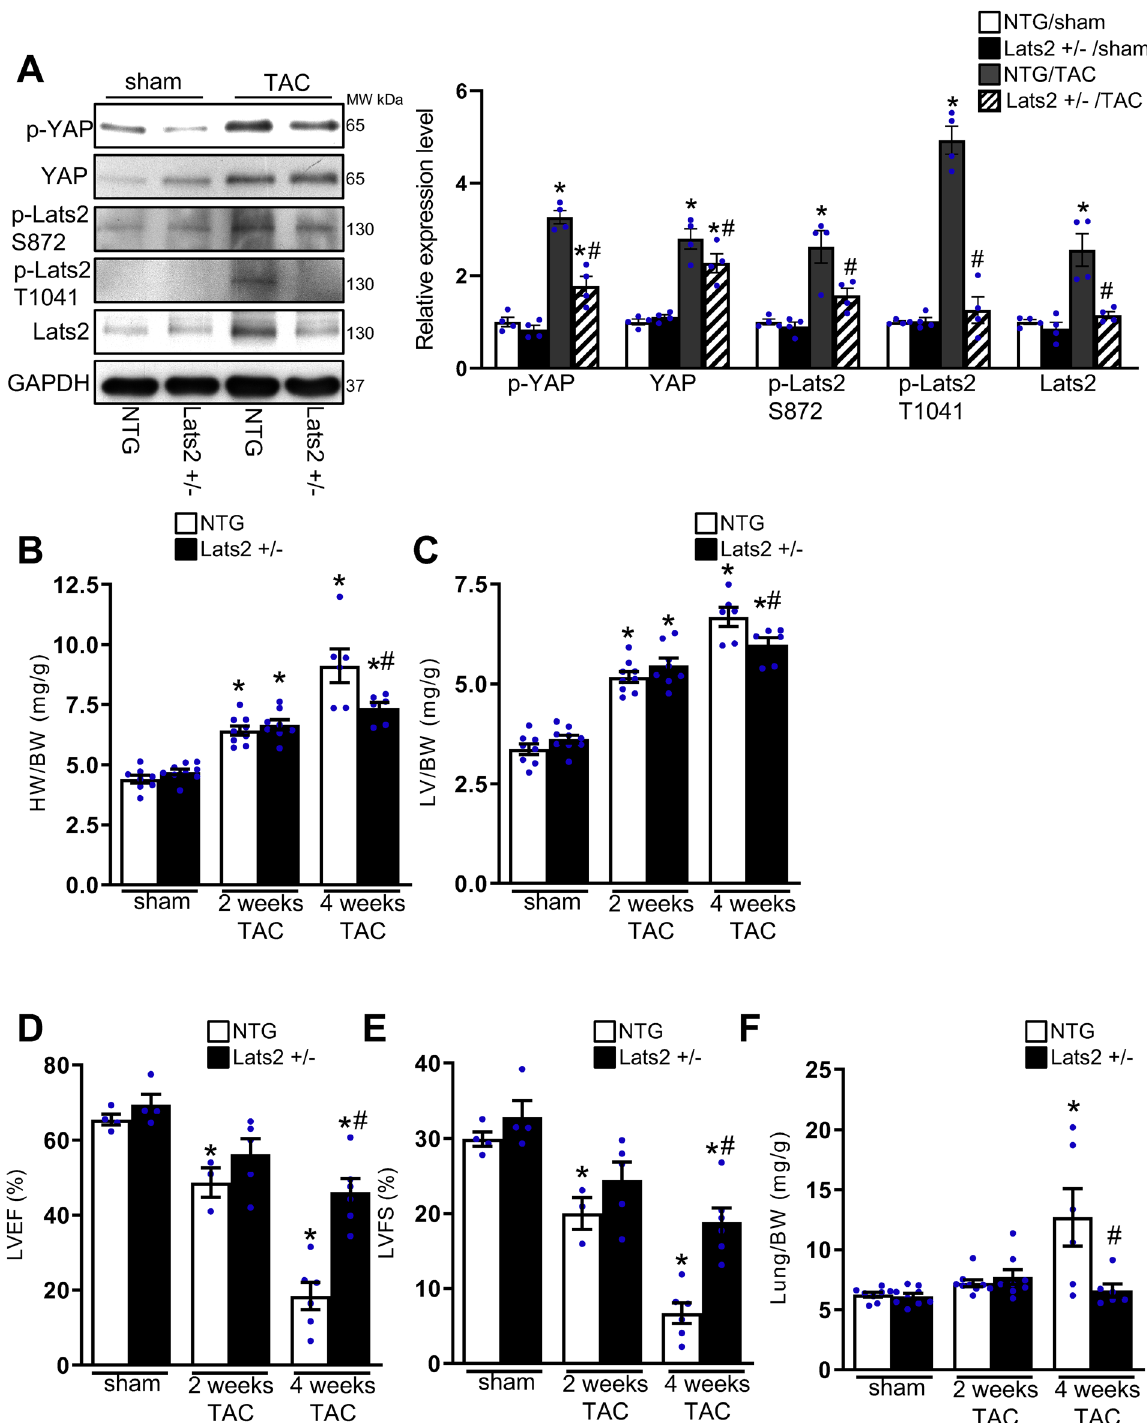
Figure 2. The effect of pressure overload in non-transgenic (NTG) and Lats2 +/- mice. NTG and Lats2 +/- mice were subjected to either transverse aortic constriction (TAC) or sham operation for either 2 or 4 weeks. The results from the 2 and 4 weeks sham groups were combined. ( A ), The levels of Ser127 phosphorylated YAP, total YAP, Ser872 phosphorylated Lats2, Thr1041 phosphorylated Lats2, total Lats2, and GAPDH in the heart homogenates prepared from NTG and Lats2 +/- mice subjected to either TAC or sham operation for 4 weeks. Representative images (left) and quantification (right) are shown (n = 4). ( B ) and ( C ), Heart weight/ body weight (HW/BW) ( B ) and left ventricular weight/body weight (LVW/BW). ( C ) and ( D ), Left ventricular ejection fraction (LVEF) ( D ) and left ventricular fractional shortening (LVFS) ( E ) were evaluated with echocardiographic analyses. ( F ), Lung weight/body weight (LungW/BW). In ( A – F ), * p < 0.05 versus NTG mouse hearts with sham operation. # p < 0.05 versus NTG mouse heart with TAC for 4